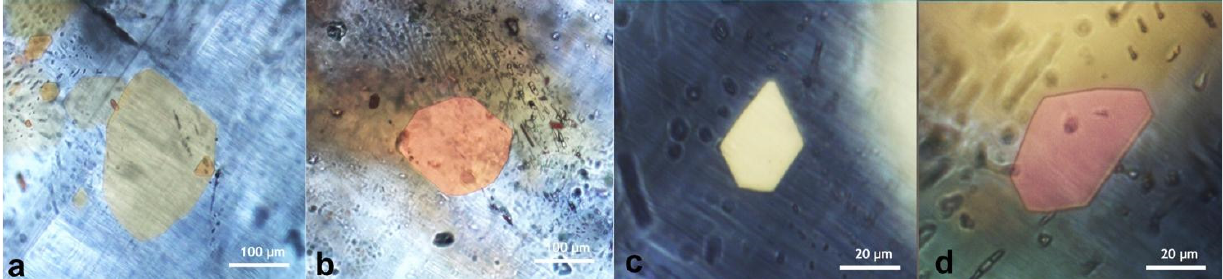
Figure 12. Platy hematite was observed in the gem host, showing subhedral ( a , b ) to euhedral ( c , d ) hexagonal crystal habit with a yellow to brown color.